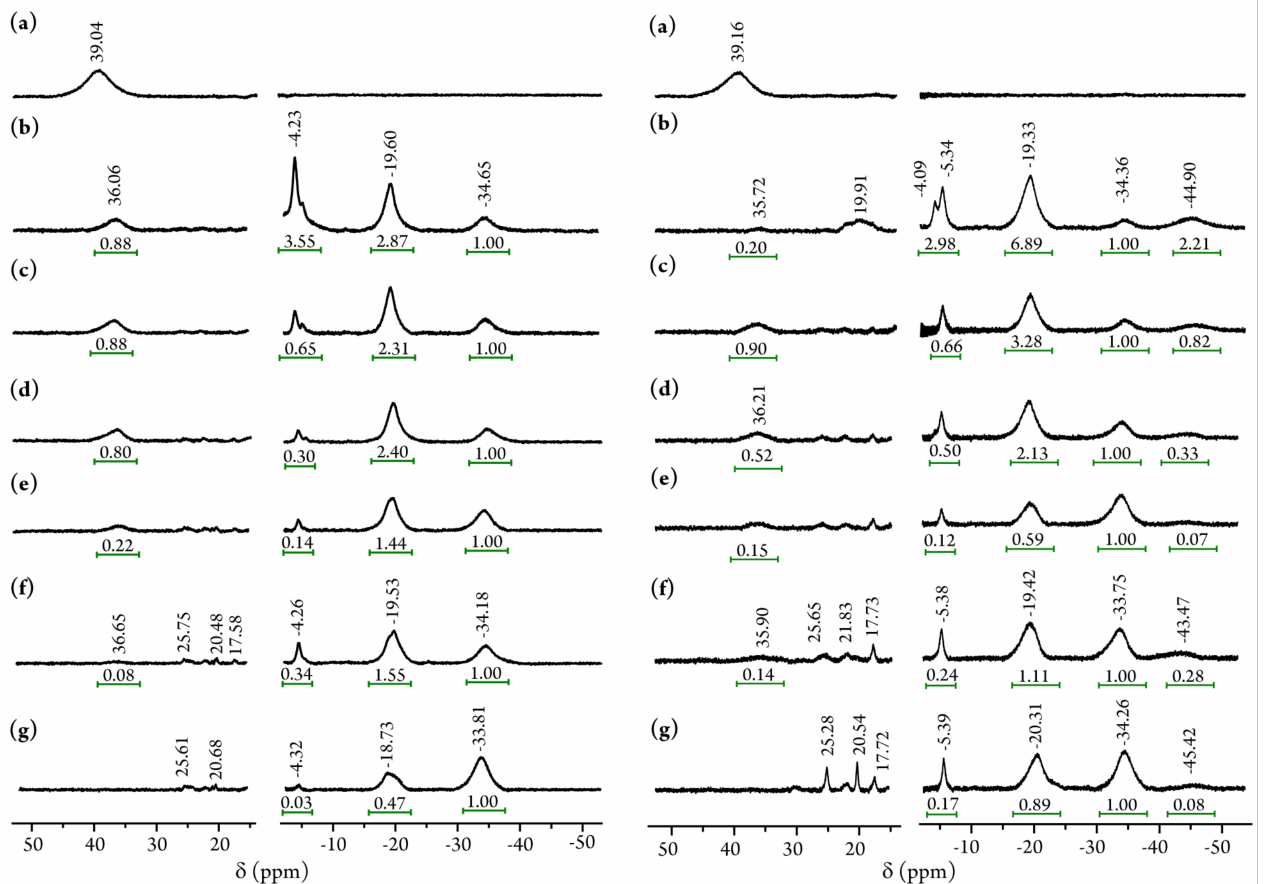
Figure 5. Parts of the 1 H-NMR spectra of the oxygenation reaction of a 1:1 mixture, ( Left ), and 1:2 mixture, ( Right ), of [(TPP)Mn II ] and [(tmpa)Cu I (MeCN)][B(C 6 F 5 ) 4 ] (THF- d 8 , room temperature) at different time intervals: ( a ) 0 min, ( b ) 1 min, ( c ) 15 min, ( d ) 1 h 30 min, ( e ) 4 h 30 min, ( f ) 6 h, and ( g ) 18 h. The peak for [(TPP)Mn III (THF) 2 ] + at δ = − 34.65 ppm was set as the reference for comparing peak